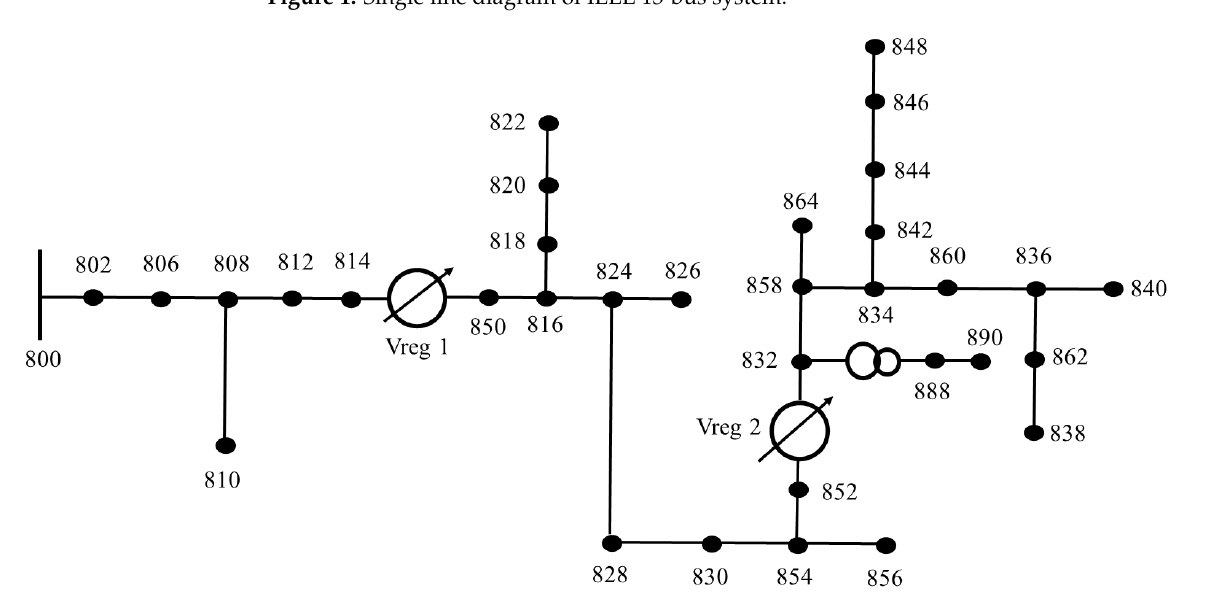
Figure 1. Single line diagram of IEEE 13-bus system.